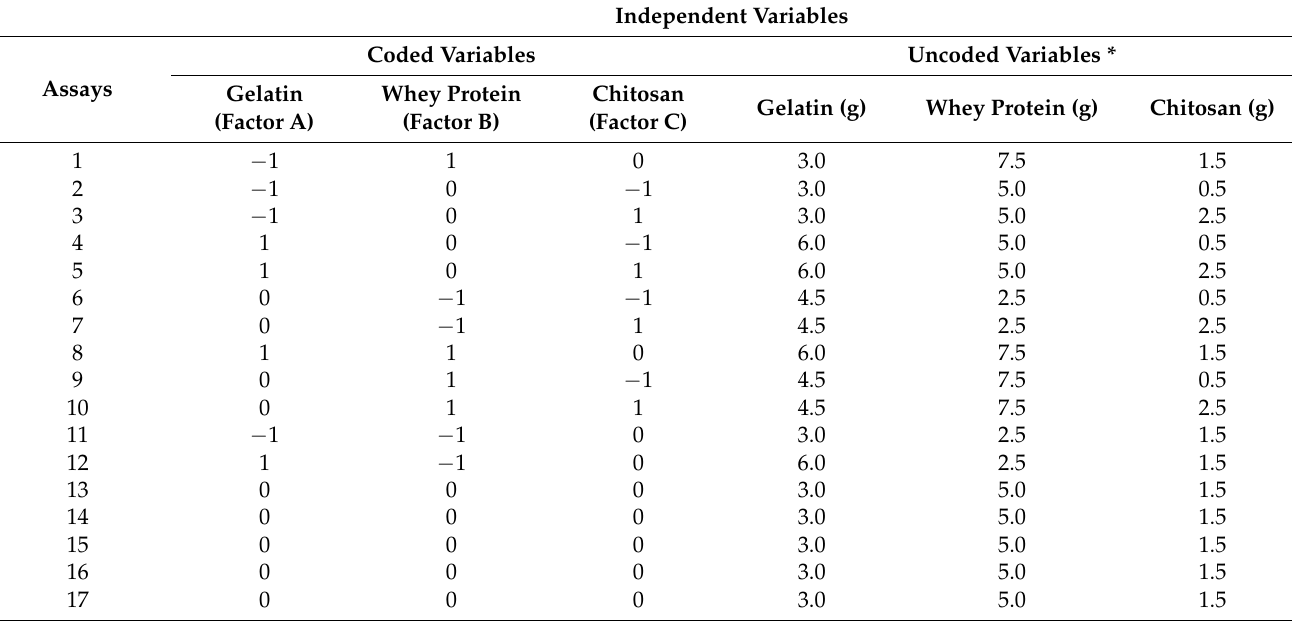
Table 1. Coded and uncoded values of independent variables and their levels used for the Box– Behnken design.